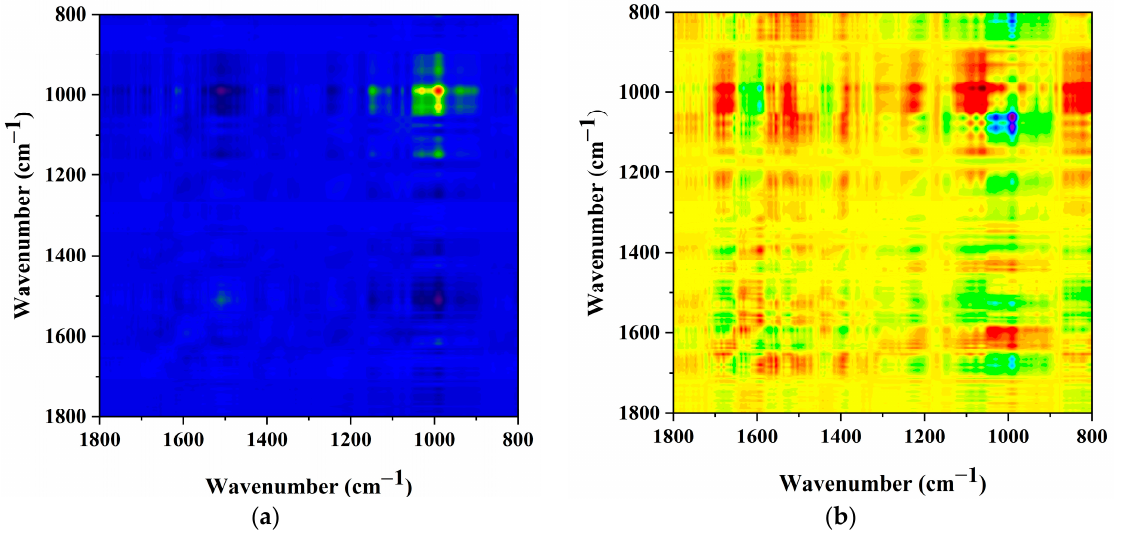
Figure 9. The 2D correlation analysis of the ATR–FTIR spectra with a range of 1800 cm − 1 to 800 cm − 1 BC pellicles with immobilised AlgL covered by P. aeruginosa PAO ‐ 1 biofilm on its surface (( a ), synchronous; ( b ), asynchronous plots).